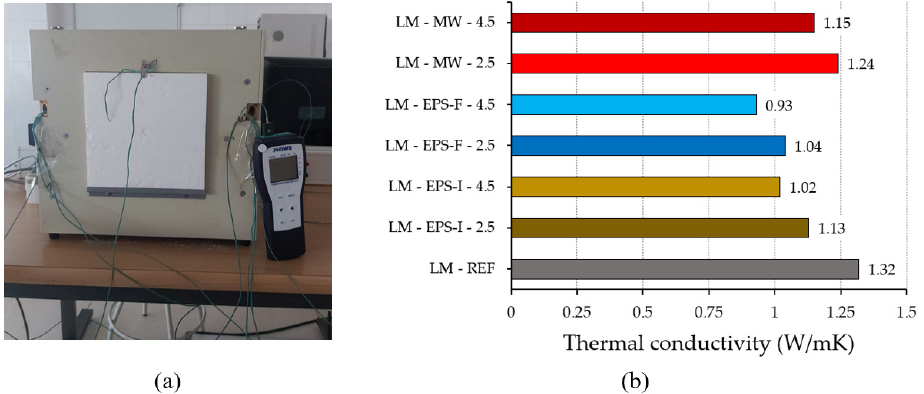
Figure 10. Thermal conductivity. ( a ) Test equipment; ( b ) results obtained for the different mortars with incorporation of thermal insulation material. Table 17. Statistical analysis for thermal Conductivity (W/mK) in each group of mortar and its